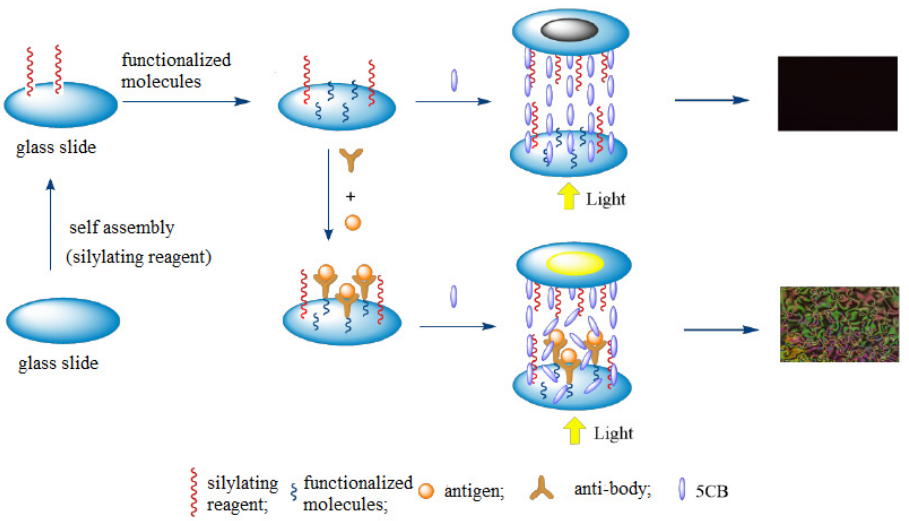
Figure 4. Diagram of the LC–solid interface sensing principle.